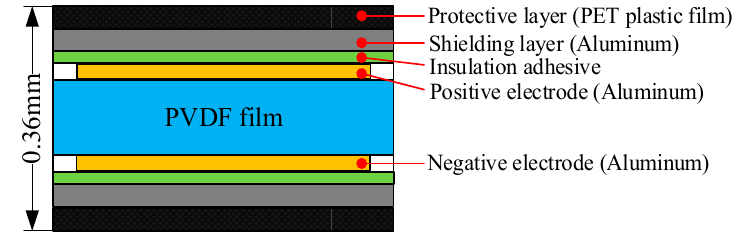
Figure 1. Cross-sectional view of the PVDF sensor (single sensing point) .